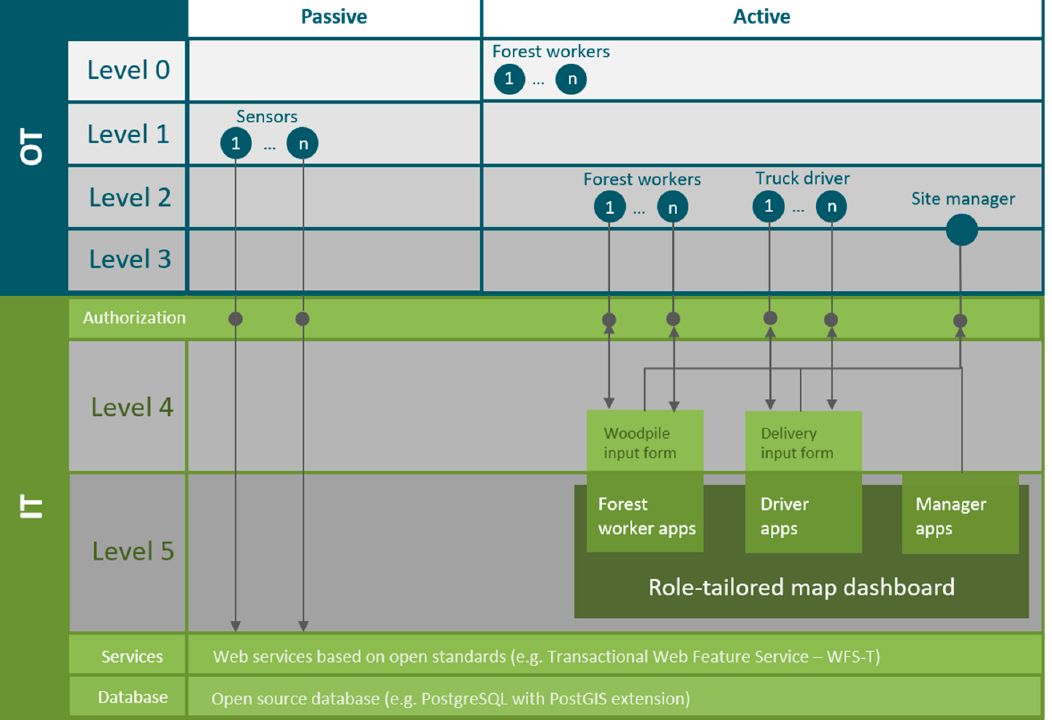
Figure 3. Passive and active components of the role-tailored map dashboard with regard to the ISA-95 standard levels (based on [64]).